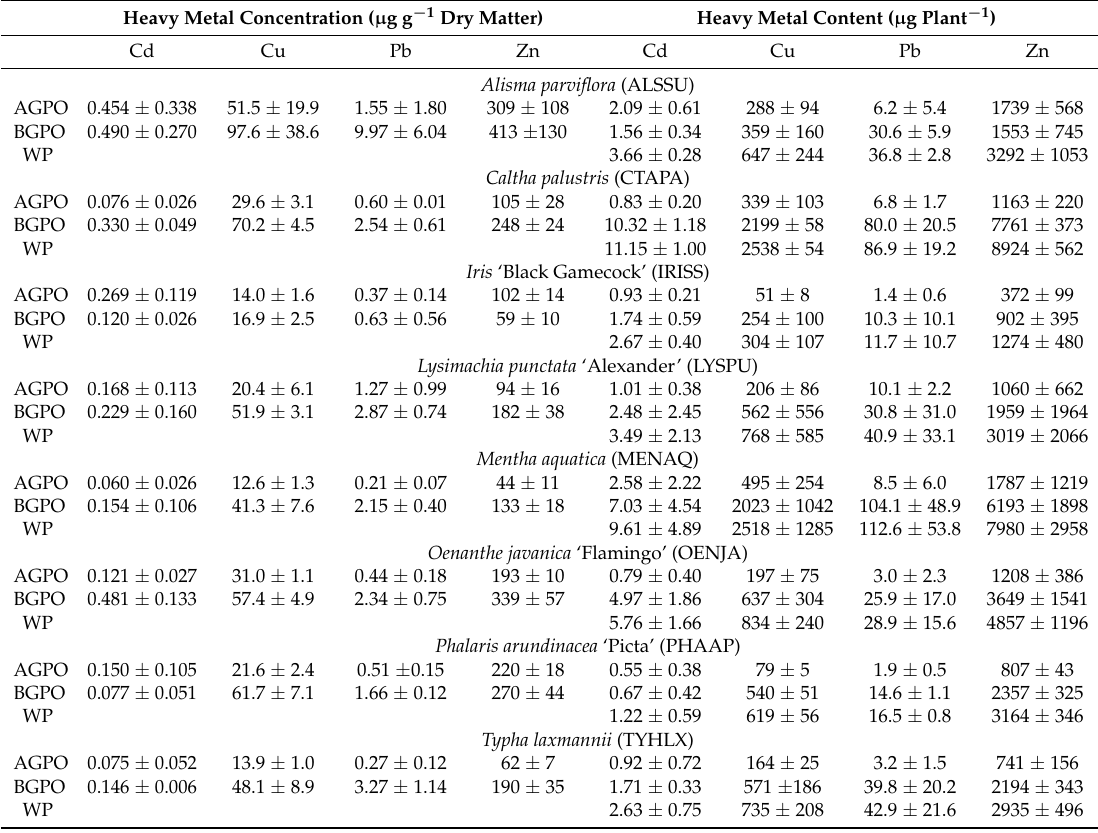
Table 5. Heavy metal concentration and content (mean ± standard deviation) in the dry matter of AGPO, BGPO, and WP of the species cultivated with the